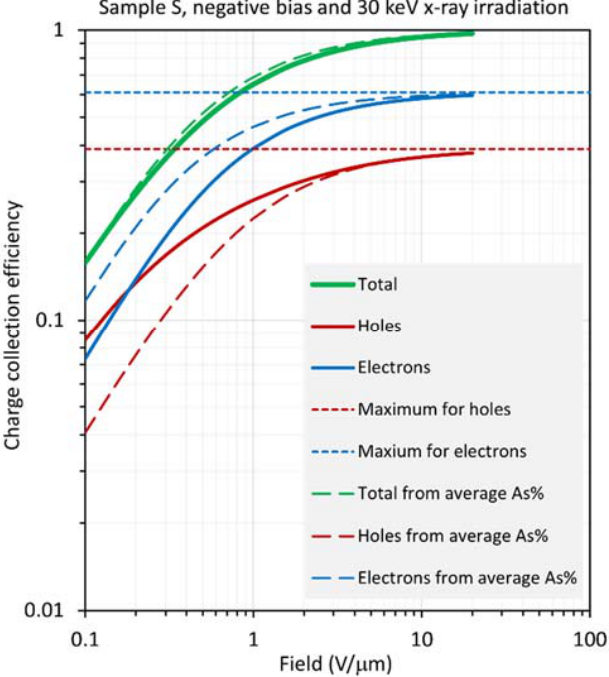
Figure 13. Log–log plot of the CE as a function of field for sample S (near worst case), biased negatively and exposed to X-rays with a photon energy of 30 keV, so that δ / L =0.73. It is of interest to evaluate the errors involved in CE calculations at a particular field using the RAC, and the ranges from the spatial average, RSA, and average inverse, RAI, i.e., the range values in Table 2. The CE calculations were carried out at 5 V/ µ m and the errors in CE were evaluated based on different definitions of the average range, as listed in Table 3. Only sample S is considered. For example, the error involved in calculating the HCE by using the RAC, r h av , is defined by: